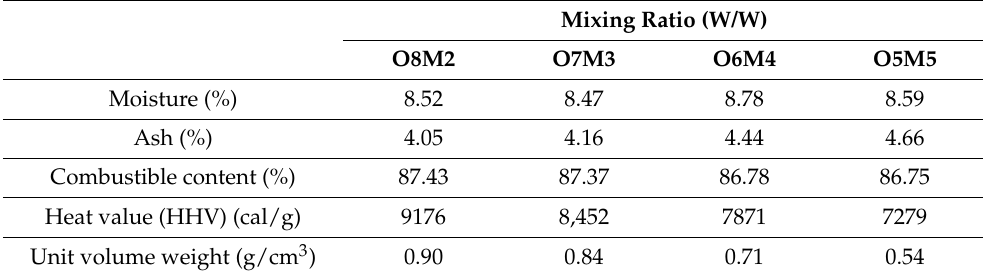
Table 2. Substance analysis of RDF produced by oily sludge and waste mushroom substrates.